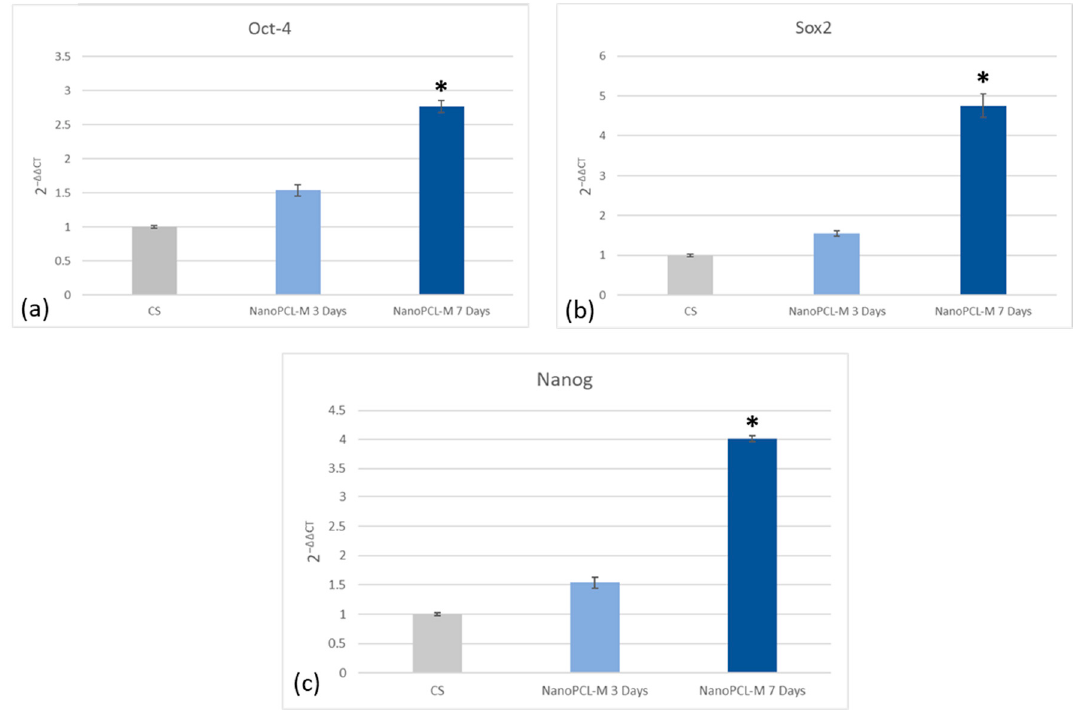
Figure 7. Effect of NanoPCL-M pretreatment on the expression of Oct-4 ( a ), Sox2 ( b ) and Nanog ( c ). Skin stem cells exposed (T) or not (CS) to three to seven days of NanoPCL-M pretreatment were stressed by UV light. The amount of mRNA from NanoPCL-M treated cells was normalized to HPRT1 and was plotted as fold change (2 −∆∆ CT ) relative to the mRNA expression of UV stress control (CS). * p value ≤ 0.05